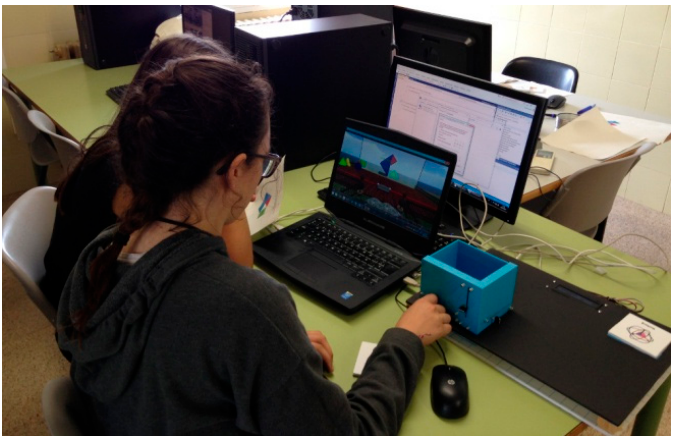
Figure 8. A student working on Activity 1 using the PrimBox tangible.